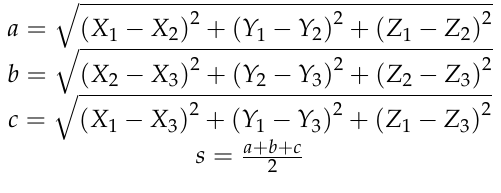
that the two points are in agreement. As shown in Figure 5, the shaded region represents